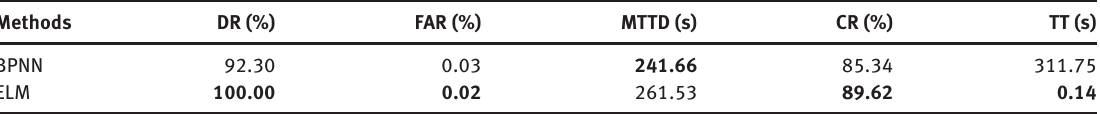
Table 1: Comparison between BPNN and ELM in Terms of Indices of Performance and Training Time.